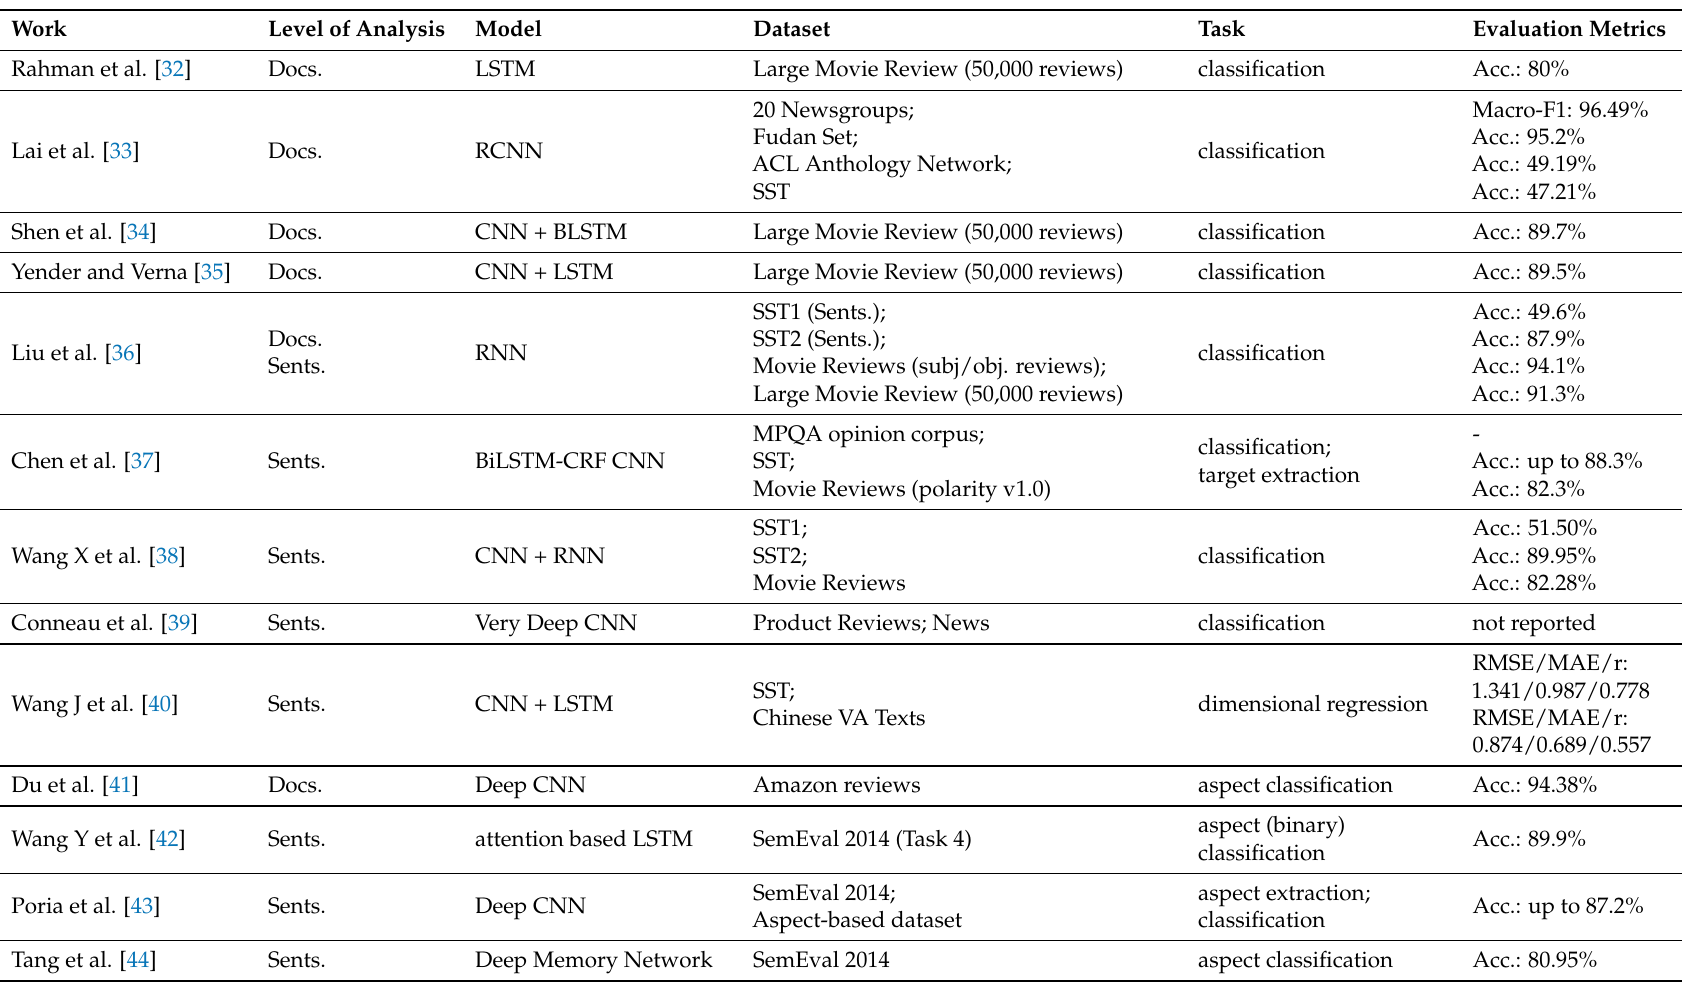
Table 1. Main characteristics of some of the latest published deep neural network models for sentiment analysis (SA) tasks. The table reports the level of analysis, the type of the deep neural network that has been applied (model), the datasets used, the type of task, and the evaluation metrics. The latter are labeled as